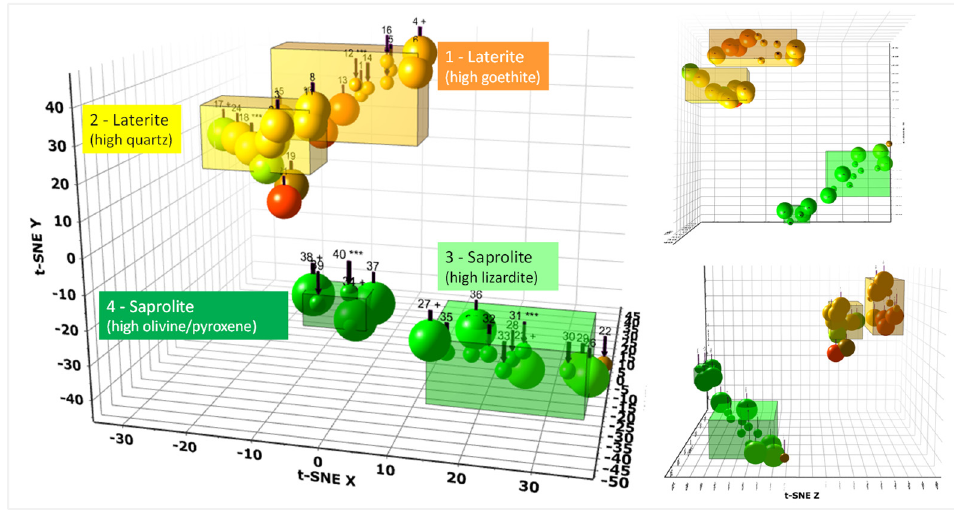
Figure 6. Fuzzified 3D t-SNE score plot, phase mixtures are indicated by mixed colors and larger spheres.